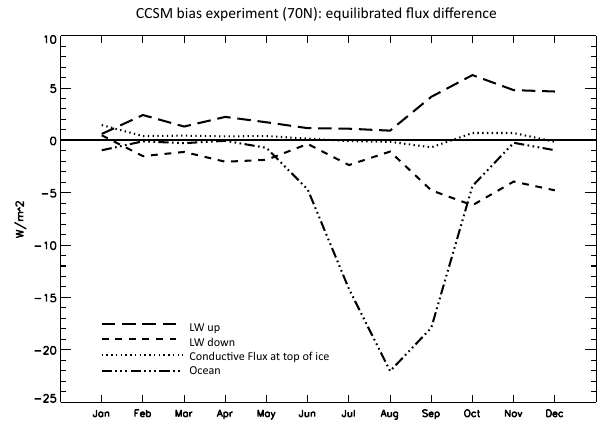
Fig. 10. Monthly mean difference in energy transfer between ex- perimental and control simulations during the equilibrated period (final 20 of 60yr) for CCSM bias sensitivity. As in Fig. 10, positive anomalies indicated more flux to the ice or less flux away from the